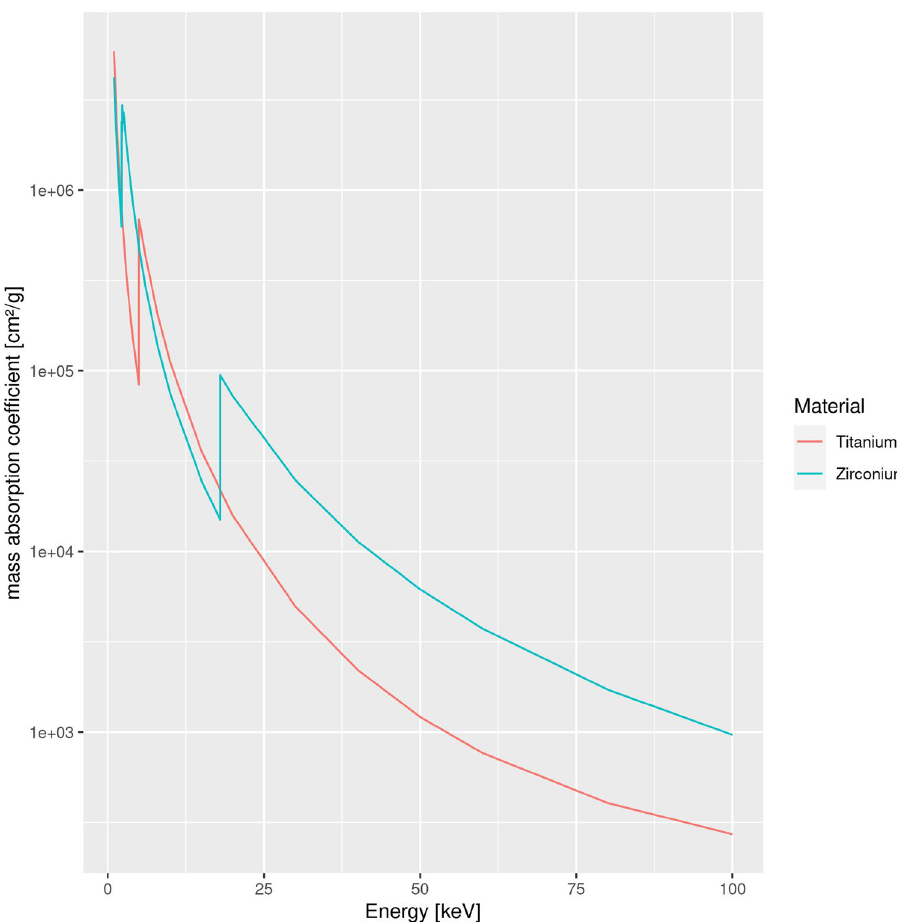
Figure 7. Plot of the mass attenuation coefficient for titanium and zirconium (as main compound of Y-TZP) for beam energies from 1 to 100 kVp (data taken from: